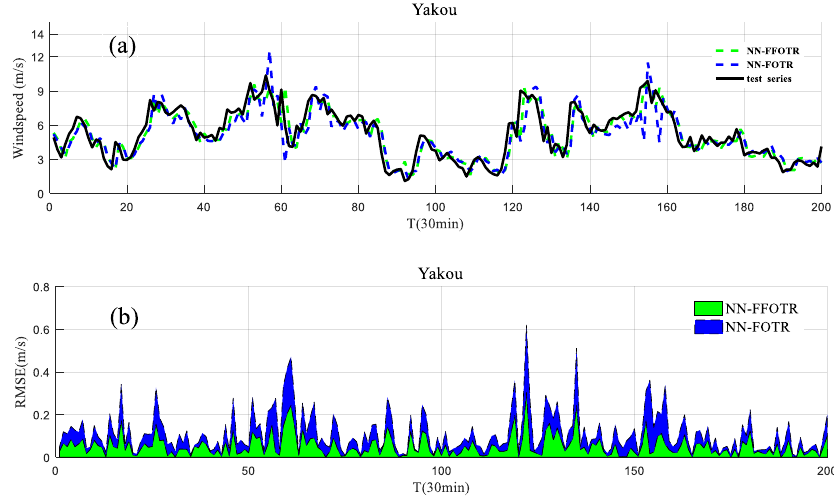
Figure 5. Results for the wind speeds at the Yakou site. ( a ) Prediction, ( b ) RMSEs.